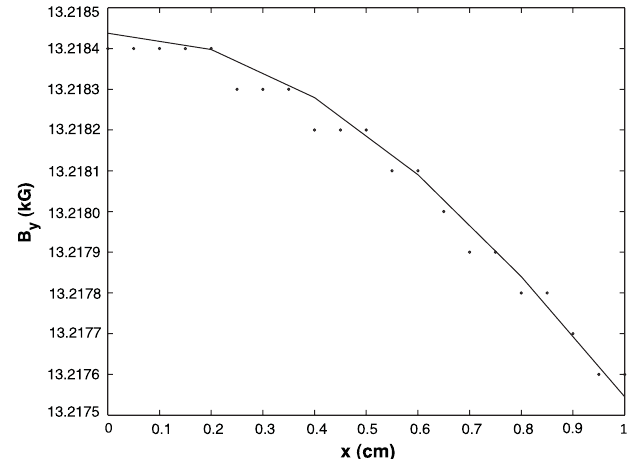
FIG. 22. Fit to the proposed ILC wiggler vertical field versus x , where y ¼ 0 : 1 cm , z ¼ 104 : 2 cm . The solid line is computed using data on the surface of an elliptical cylinder with x max ¼ ¼ 2 : 4 cm , using the polynomial series for B ob- 4 : 4 cm , y max tained from (11) or (12). Dots represent numerical data provided by OPERA-3D .